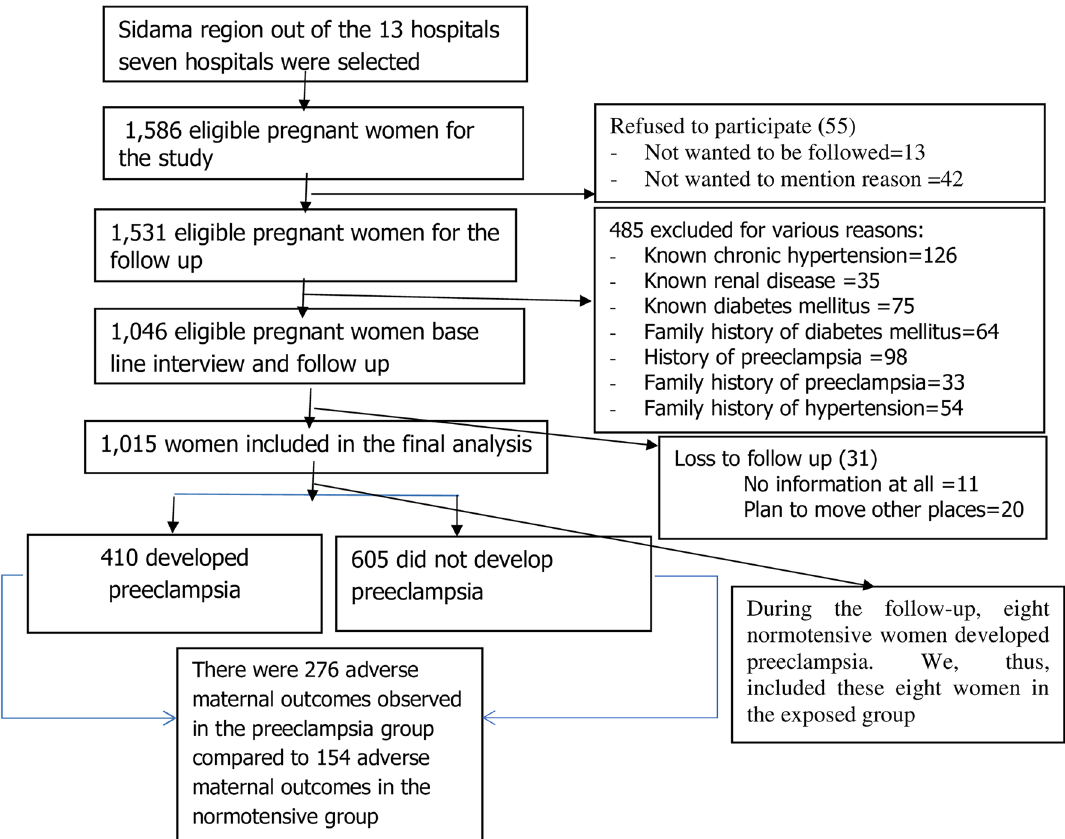
Figure 1. Flow-diagram of the overall study process in Sidama region, southern Ethiopia, August 8, 2019, to October 1,